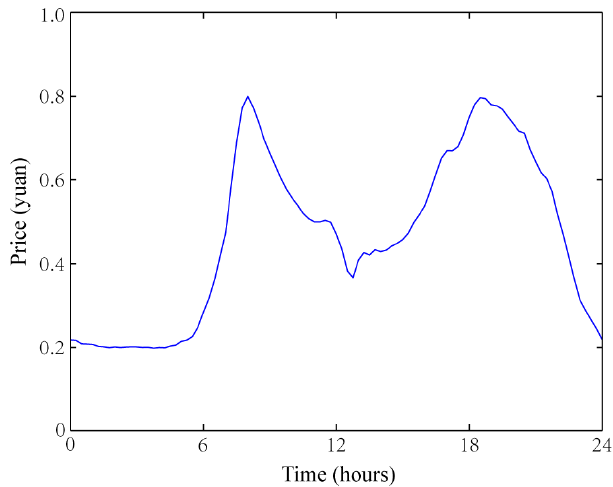
Figure 7. Day-ahead real-time pricing.